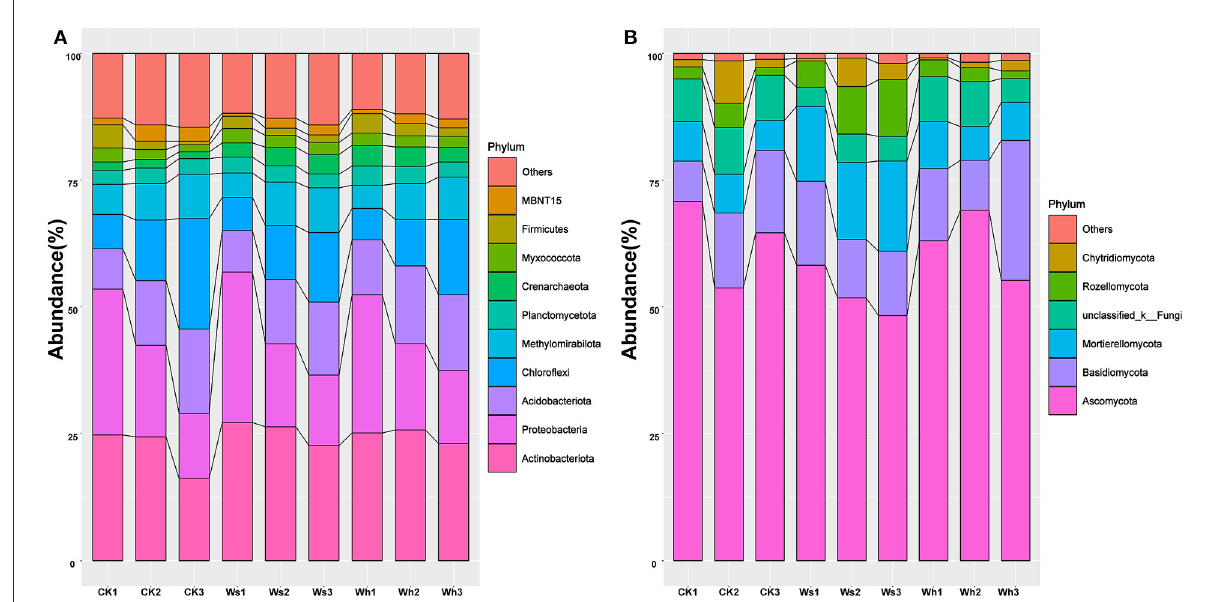
FIGURE1 Relative abundance of the dominant bacteria (A) and fungi (B) groups at phylum level at different soil layers. Ws, slight warming; Wh, high warming; CK1, 0–10cm depth in control plots; CK2, 10–20cm depth in control plots; CK3, 20–30cm depth in control plots.